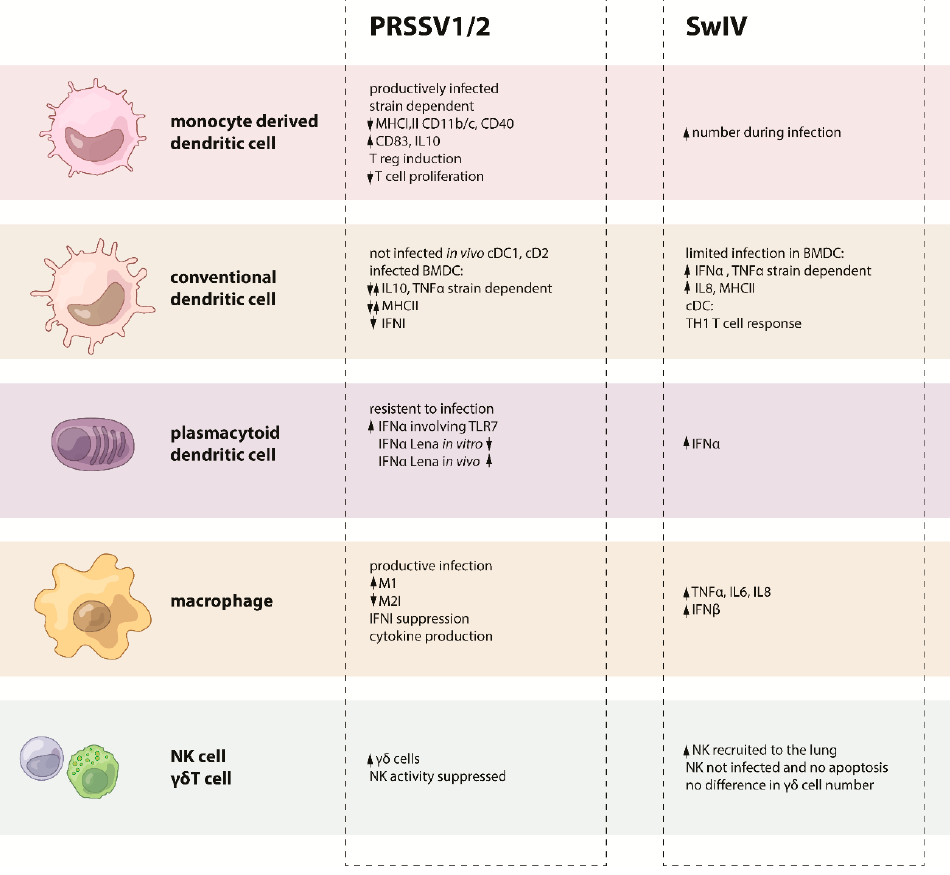
Figure 2. Summary on the PRRSV or SwIV effects on each cell from the innate immune system.